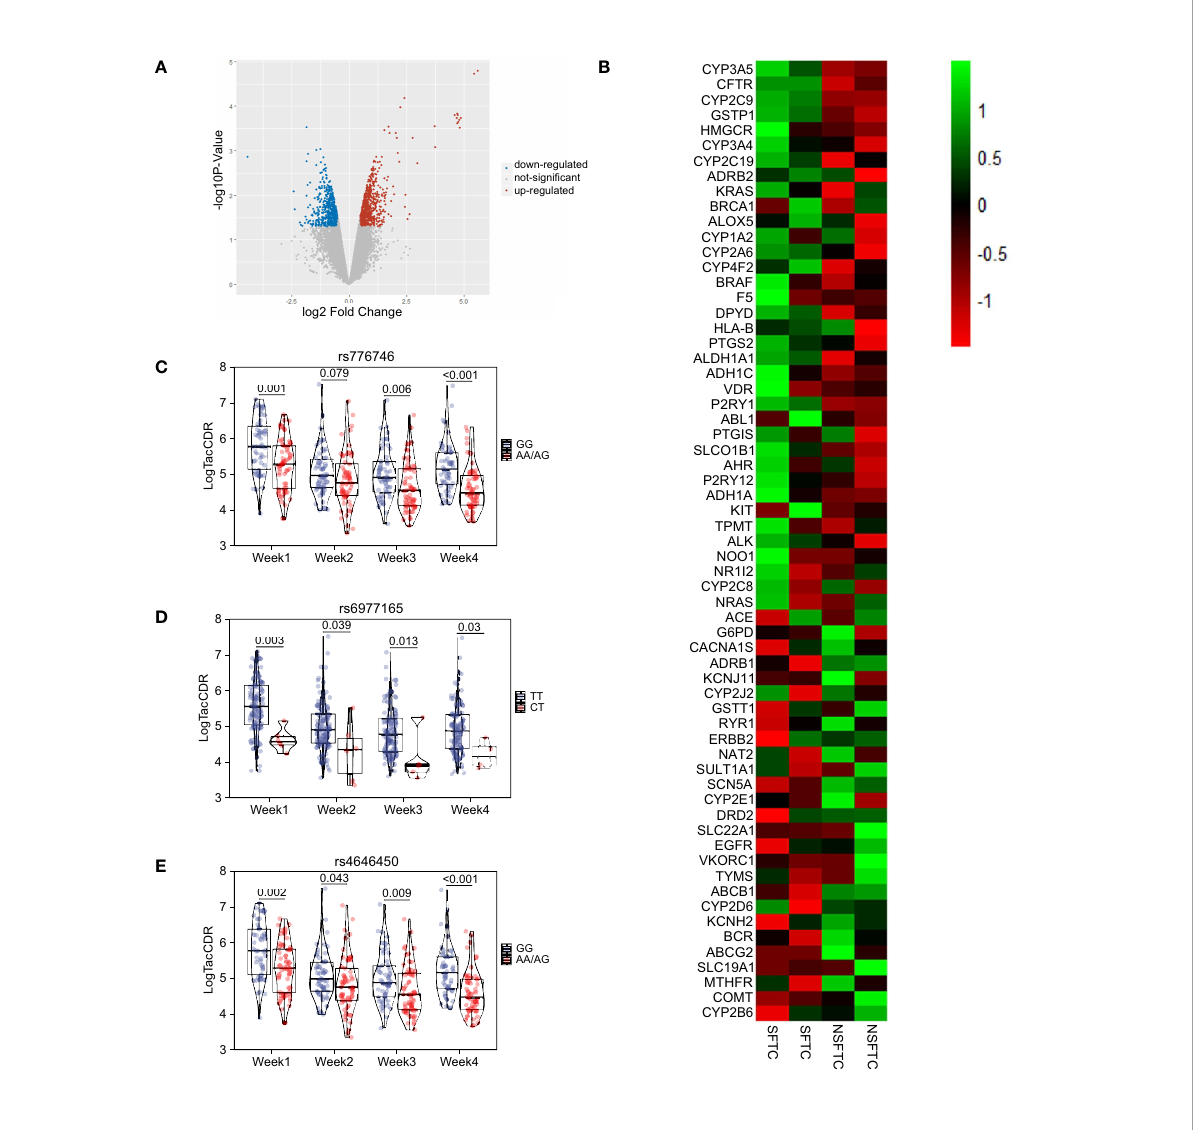
FIGURE 2 The screening of genes in fl uencing the process of Switching from FK506 to cyclosporine (SFTC). (A) Volcano plot showed the difference gene between SFTC and non-SFTC patients. Red dots represent upregulated genes, and blue dots represent downregulated genes; (B) Heatmap showed the very important pharmacogenetic genes expression level between SFTC and non-SFTC patients; (C) Comparison of tacrolimus pharmacokinetics at fi rst four weeks in different genotype groups (AA/AG vs GG) of donors ’ CYP3A5 rs4646450; (D) Comparison of tacrolimus pharmacokinetics at fi rst four weeks in different genotype groups (CT vs TT) of donors ’ CYP3A5 rs6977165; (E) Comparison of tacrolimus pharmacokinetics at fi rst four weeks in different genotype groups (AA/AG vs GG) of donors ’ CYP3A5 rs776746. P less than 0.05 means statistical signi fi